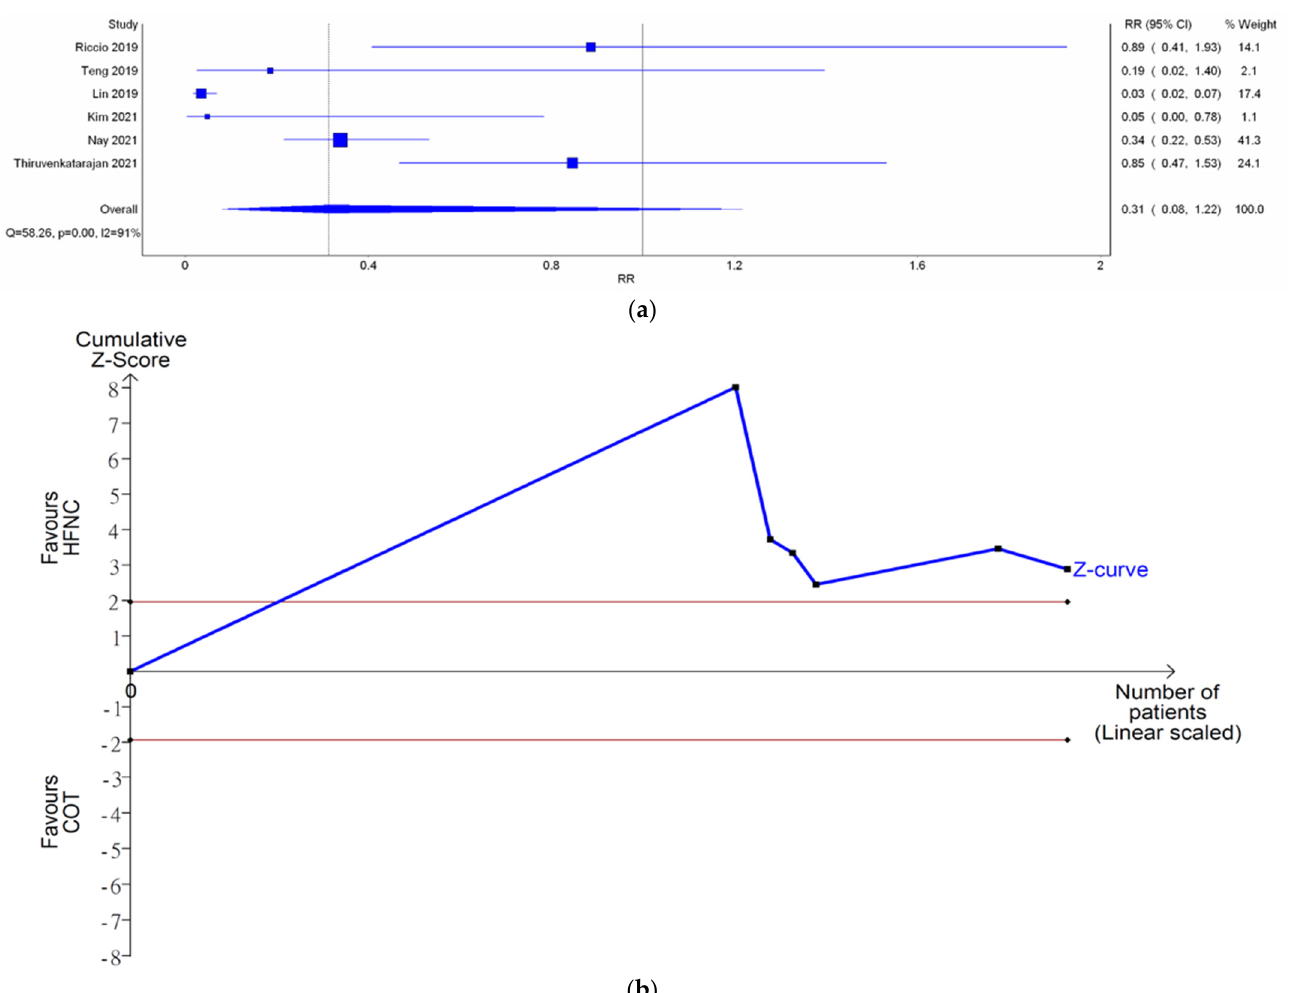
Figure 5. Need for minor airway interventions. ( a ) Meta-analysis with IVhet model; and ( b ) trial sequential analysis. Riccio et al. [13], Teng et al. [12], Lin et al. [11], Kim et al. [17], Nay et al. [16], Thiruvenkatarajan et al.